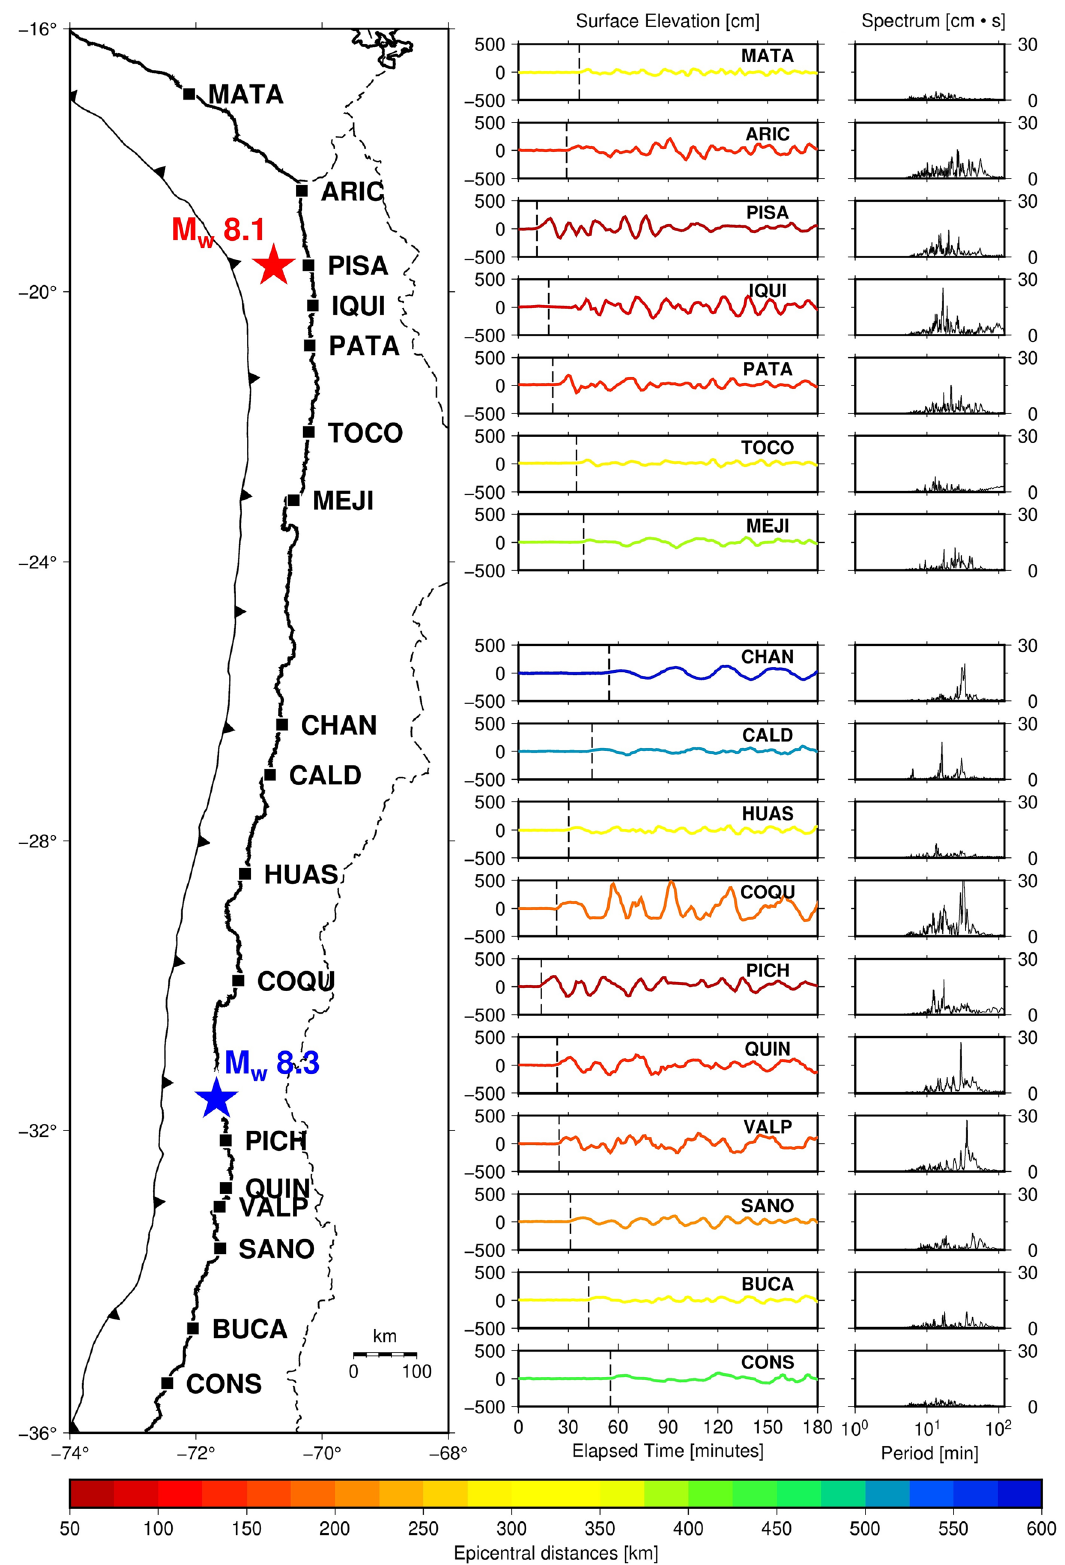
Figure 2. Tide-gauge locations along the Chilean coastal region (left panel). The tsunami waveform for the Pisagua and Illapel earthquakes are shown in central panel. The data were filtered using a zero-phase digital high-pass filter to eliminate signals over 180 min period. The dotted lines show the first arrival of tsunamis to the tide-gauge sites. Tsunami spectra of 24 h of elapsed time are shown in right